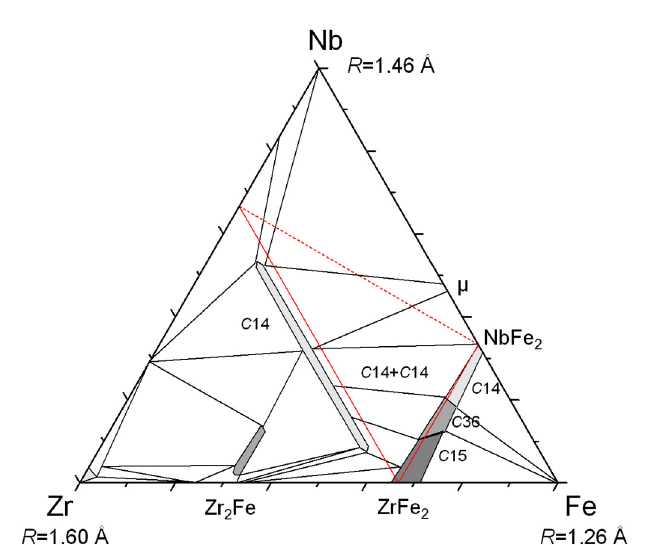
Figure 5. Isothermal section at 800 °C of the Zr–Nb–Fe system (redrawn from [14,15]). The red triangle shows the three ordered stable or metastable compositions of the Laves phase: ZrNb 2 , ZrFe 2 , and NbFe 2 , as in Figure 2 (solid lines: normal substitution, dashed line: site